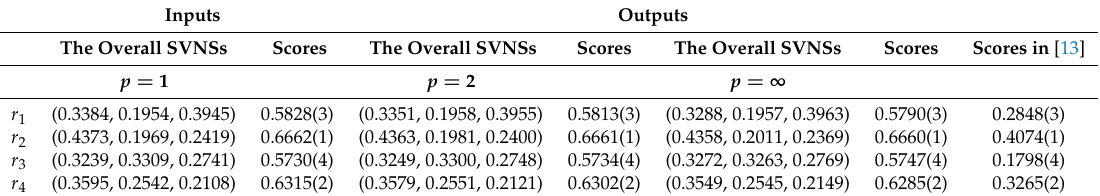
Table 4. The overall SVNSs and associated rankings (in parentheses) with respect to partly known attribute weights. Inputs Outputs Scores Scores The Overall SVNSs